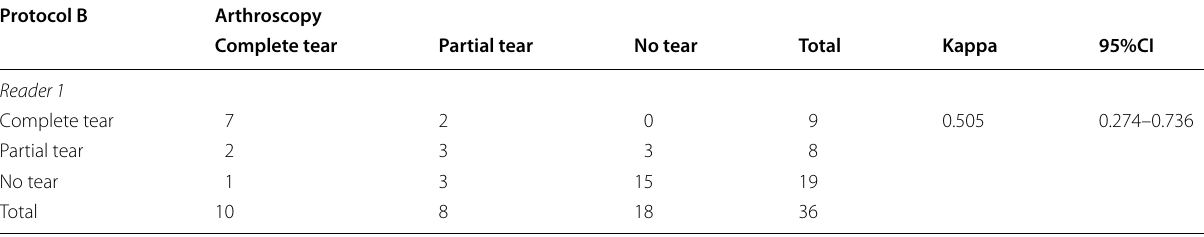
Table 5 MRI grades of ACL graft injury in imaging protocol B versus arthroscopy according to reader 1. Diagnostic agreement between MR grade and arthroscopic grade is also included